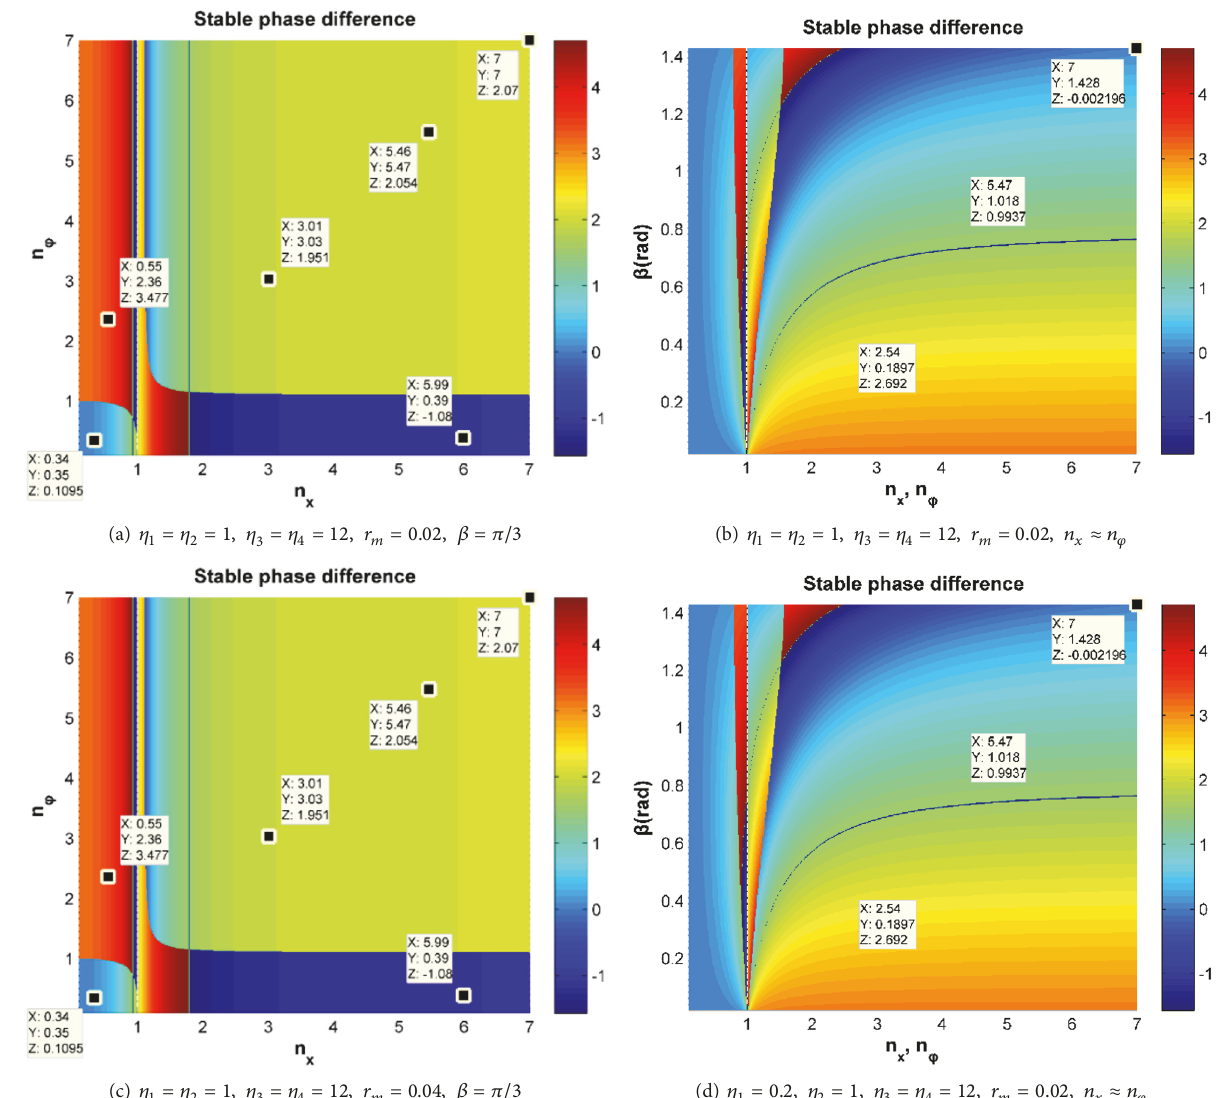
Figure 3: Stable phase difference when 𝜎 = 1